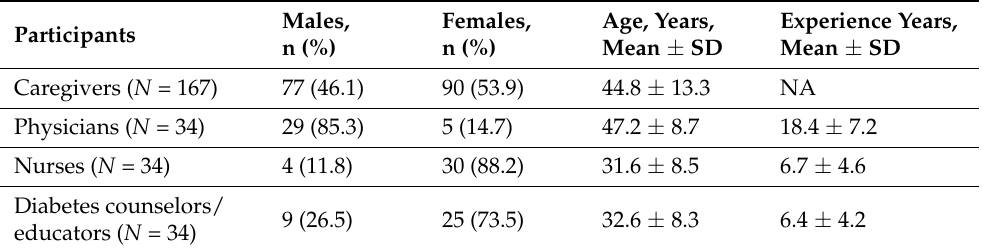
Demographic characteristics of caregivers, physicians, nurses, and diabetes coun- selors/educators.